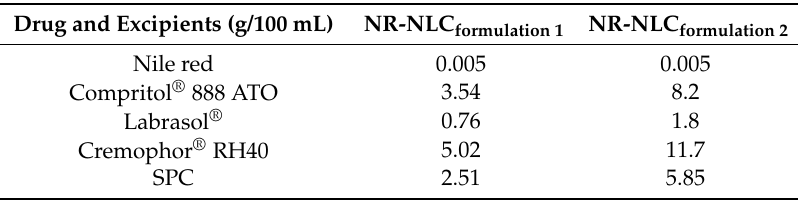
Table 2. Formulations of